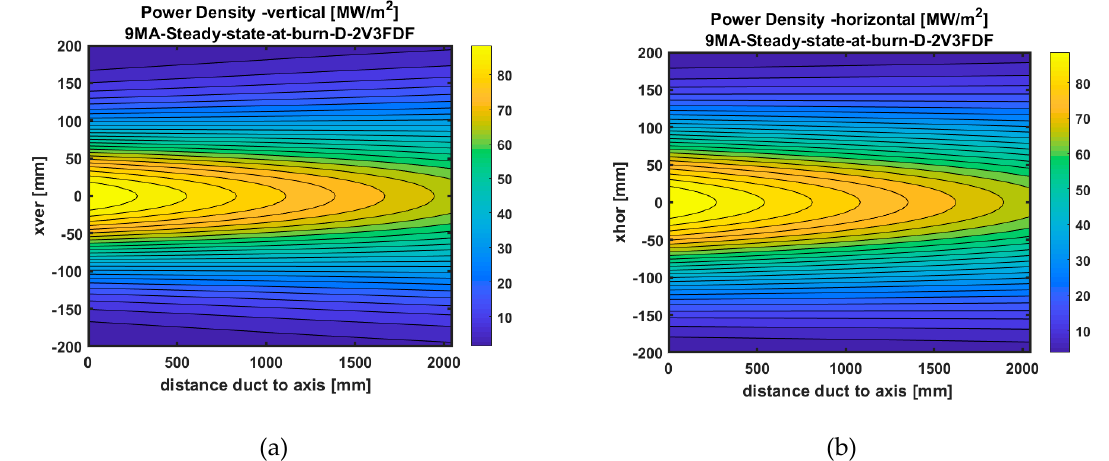
Figure 4. ( a ) ITER diagnostics neutral beam (DNB) power density profile in vertical direction versus distance from duct position (plasma-entry); ( b ) ITER DNB power density profile in horizontal direction versus distance from duct position (plasma-entry).